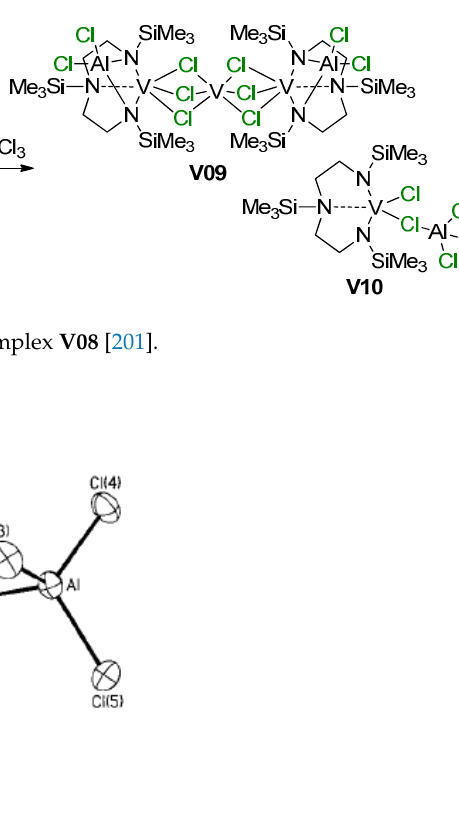
Figure 24. ORTEP plot of V10 . Thermal ellipsoids are drawn at the 30% probability level. Reprinted with permission from [201]. Copyright (2002) American Chemical Society.